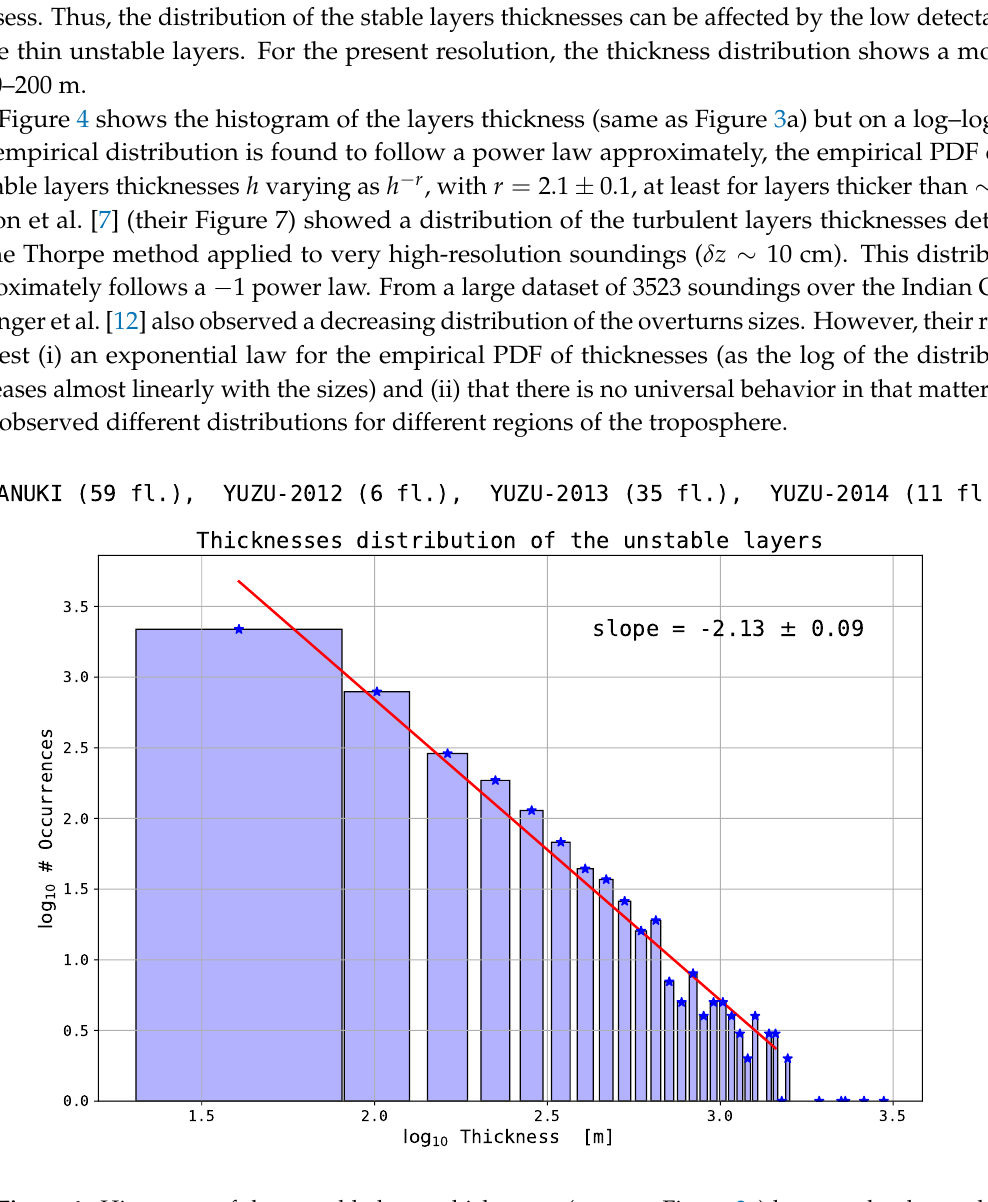
Figure 4. Histogram of the unstable layers thicknesses (same as Figure 3a) but on a log-log scale. The blue stars are the population of the class with the abscissa being at the middle (on a logarithmic scale) of the classes. The linear fit (red line) is performed on these